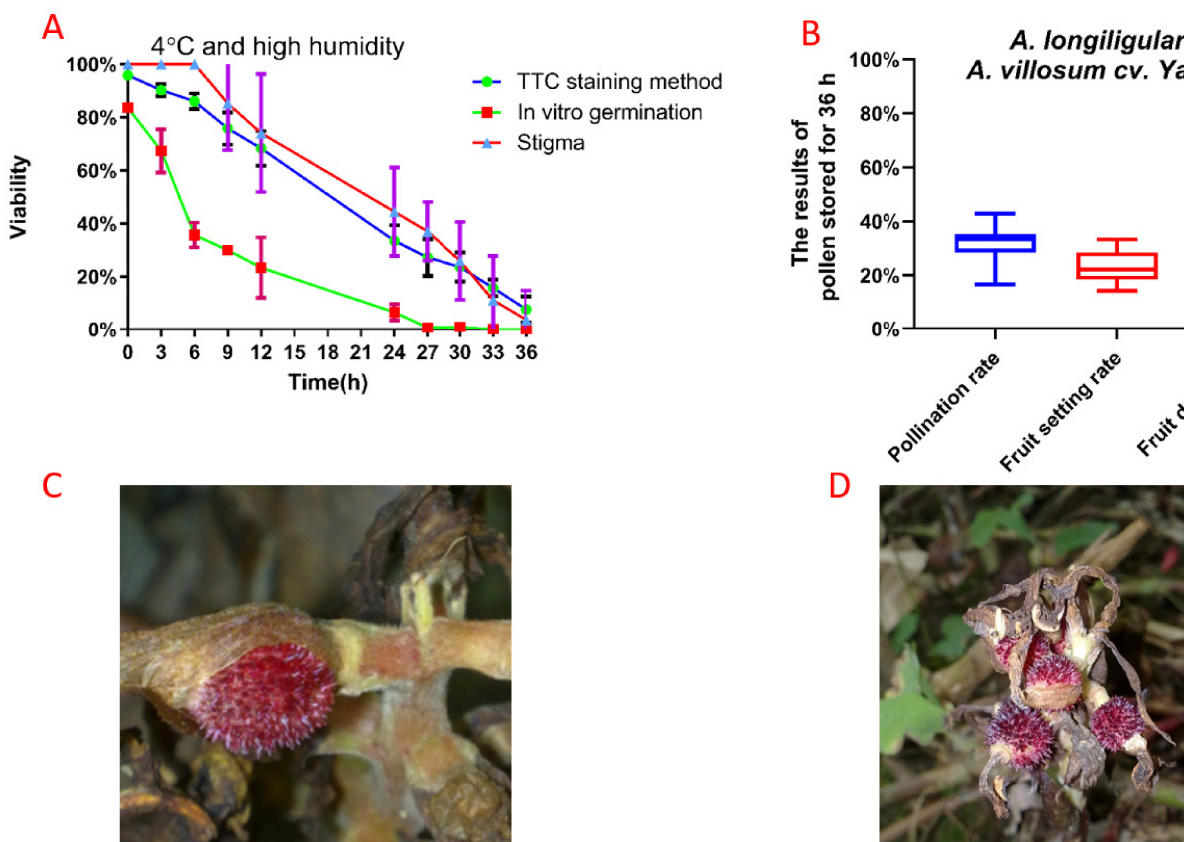
Fig 5. Verification by hybridization. (A)The pollen viability of ‘ A . longiligulare ’ stored at 4˚C and high humidity was tested by in vitro germination and the TTC staining method, (B)The results of pollen stored for 36 h, (C-D) A model for fruit set in the treatment of Hybridization in two Amomum plants.